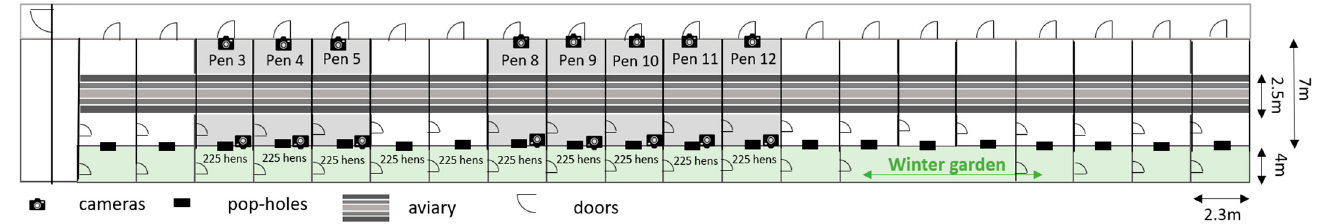
Figure 1. Housing setup, including the pens and aviary location in the barn, winter-garden zone, pop holes, and cameras. holes, and